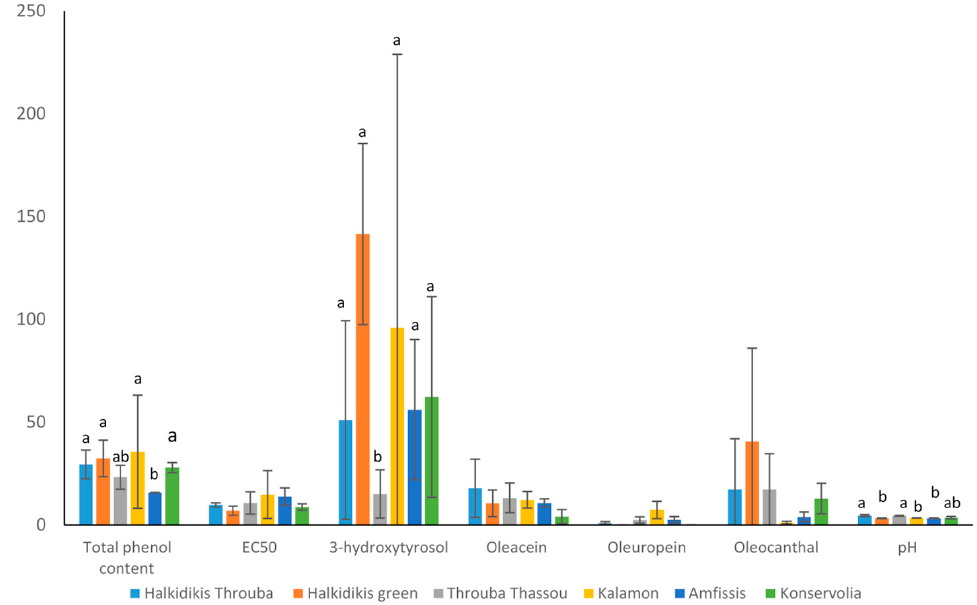
Figure 5. Biochemical values of the samples, expressed as average for each cultivar. Units of measurement are total phenol content (mg of caffeic acid/10 g of dry olives), 3-hydroxytyrosol, oleacein, oleuropein, oleocanthal (mg/100 g of dry olives). A statistically important difference ( p ≤ 0.05) is marked with a different letter.